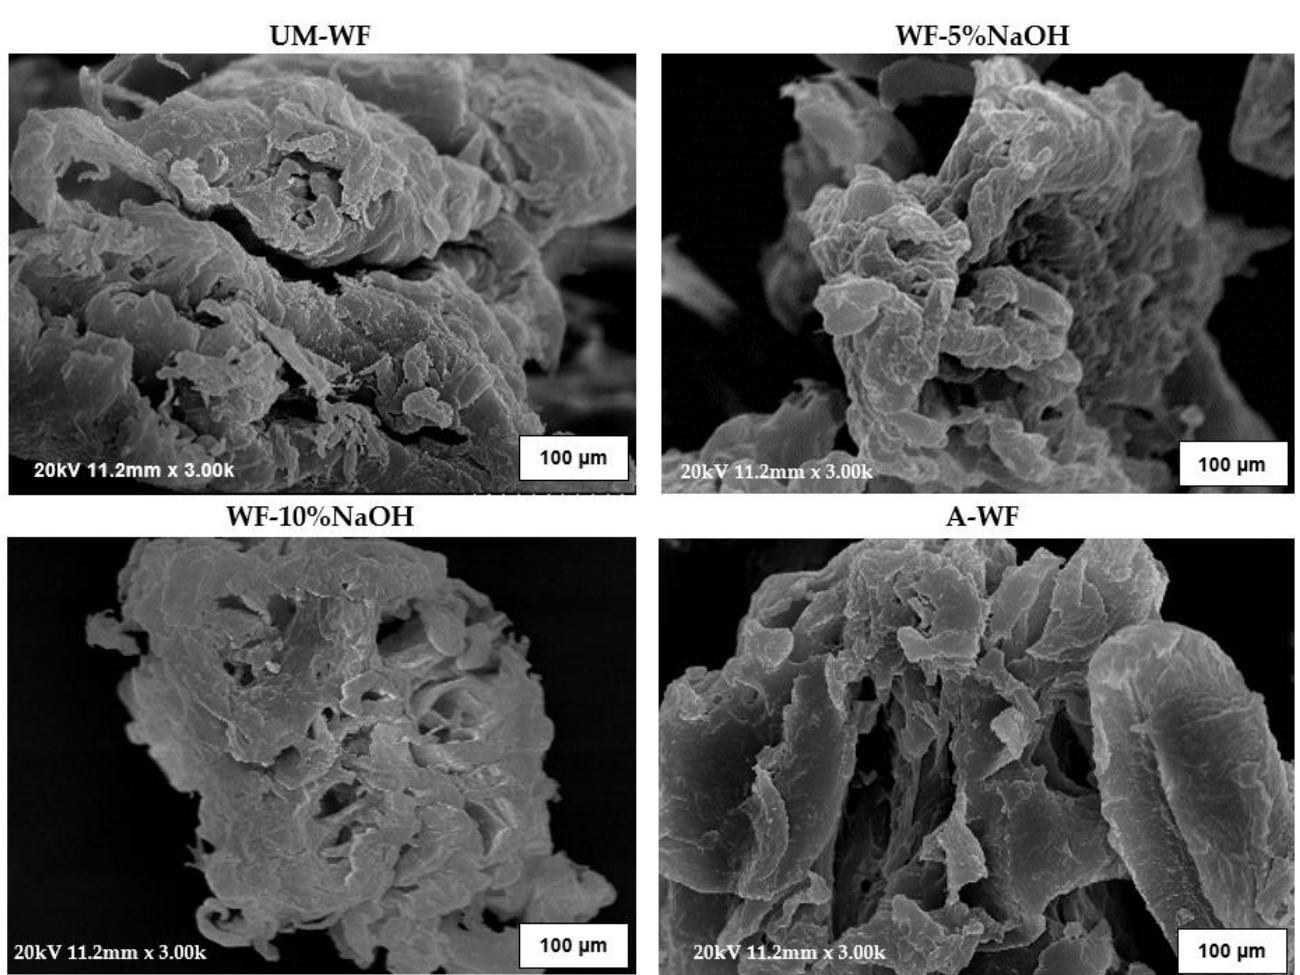
Figure 4. SEM micrographs of unmodified and modified waste oak wood